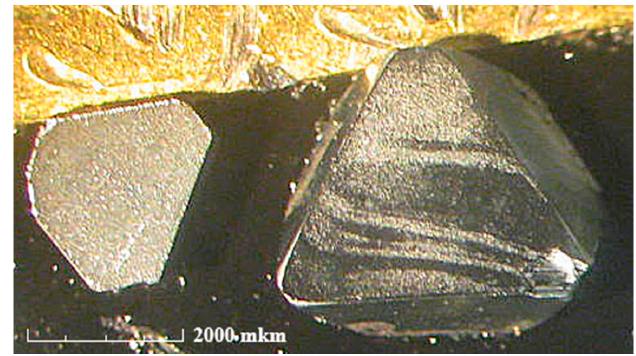
Figure 4. Boron-doped diamond samples (Sample 1—left, Sample 2—right).